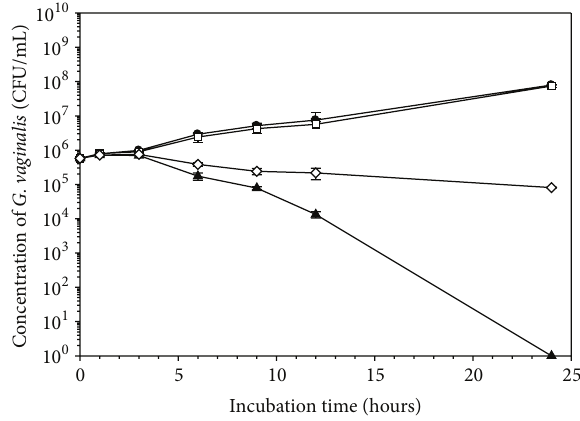
Figure 3: The effect of base gel, 1% BPO gel, and BPO particles on G. vaginalis in an indirect contact assay. All experiments were conducted twice in duplicate; ( ∙ ) represents the negative control, ( ◻ ) represents the base gel, ( 󳵳 ) represents 1% BPO hydrogel, and ( ◊ ) represents BPO particles. Mean values and standard deviations are shown.